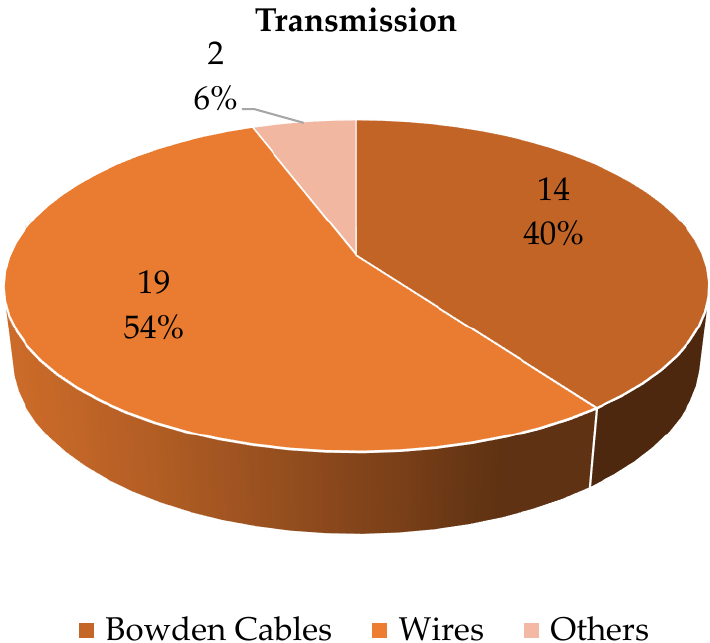
Figure 34. Distribution of implemented solutions for tendon-driven